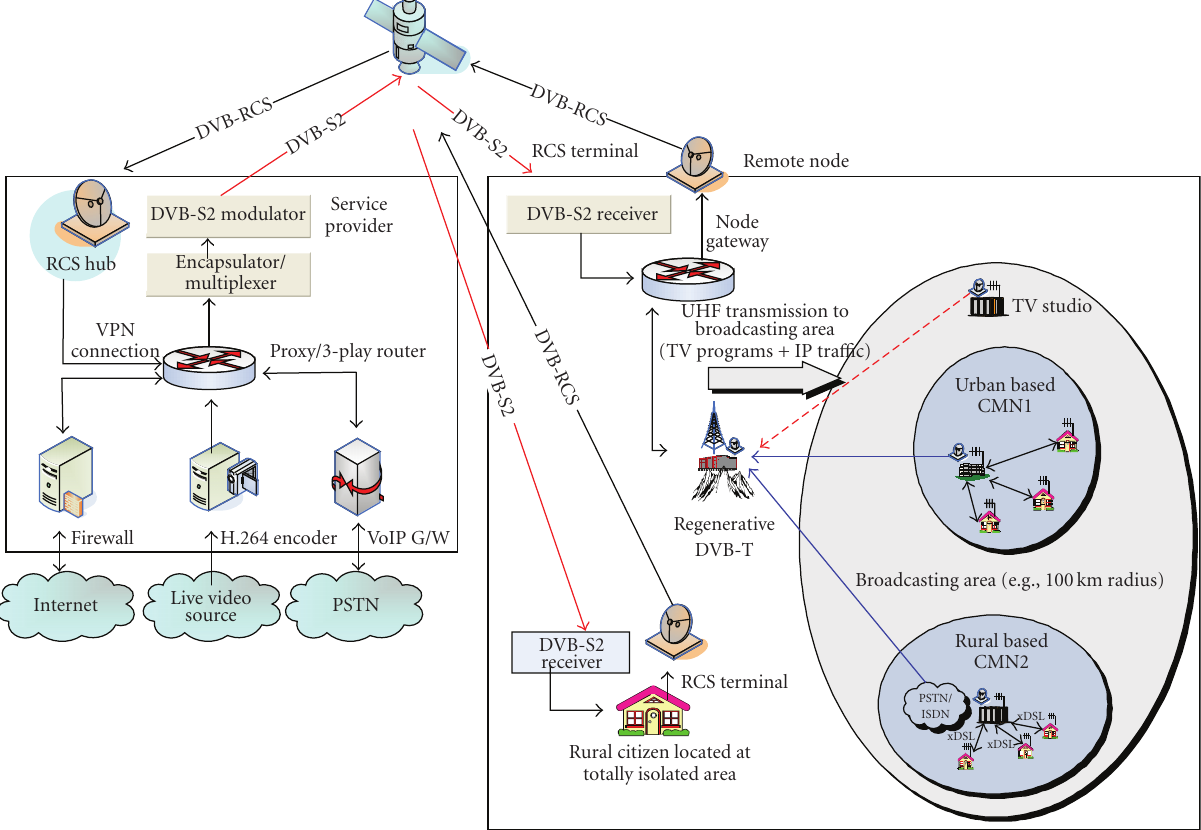
Figure 9: Overall architecture and configuration of the satellite DVB/IP